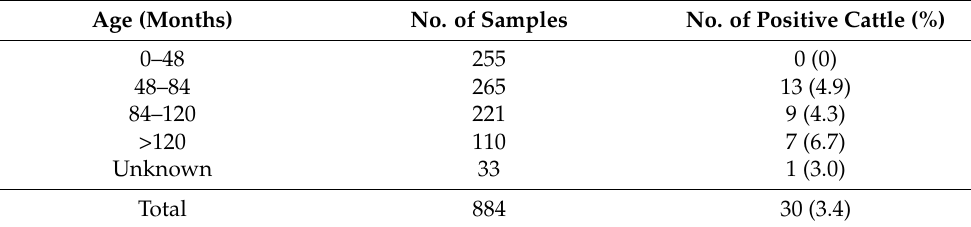
Table 2. Prevalence of bovine foamy virus among the age groups of